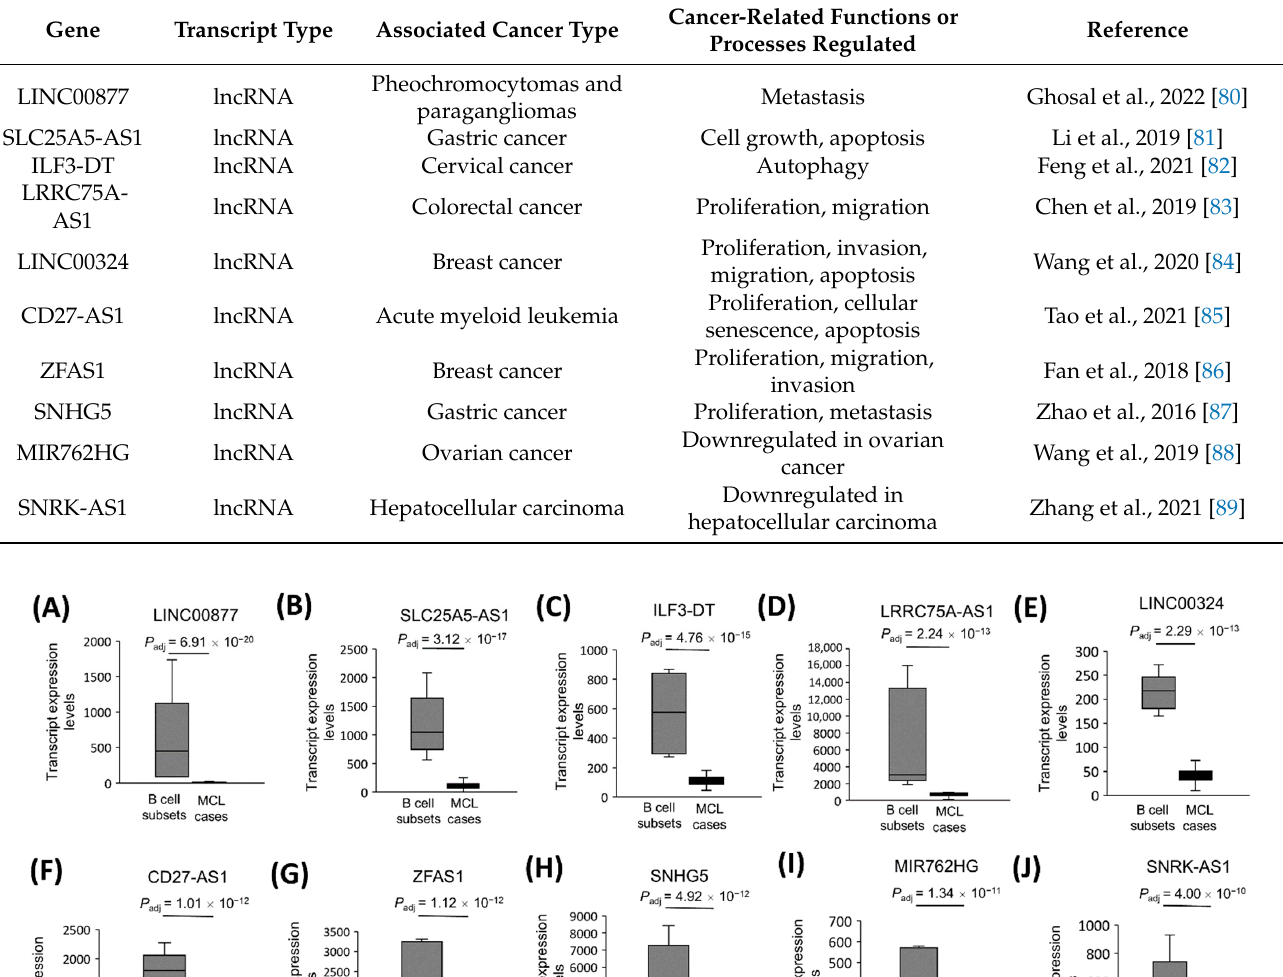
(Figure 8H), MIR762HG (Figure 8I), and SNRK-AS1 (Figure 8J) were the top significantly downregulated tumor suppressor candidates in MCL cases. Table 4. List of the top 10 underexpressed tumor suppressor candidate lncRNAs in MCL cases.